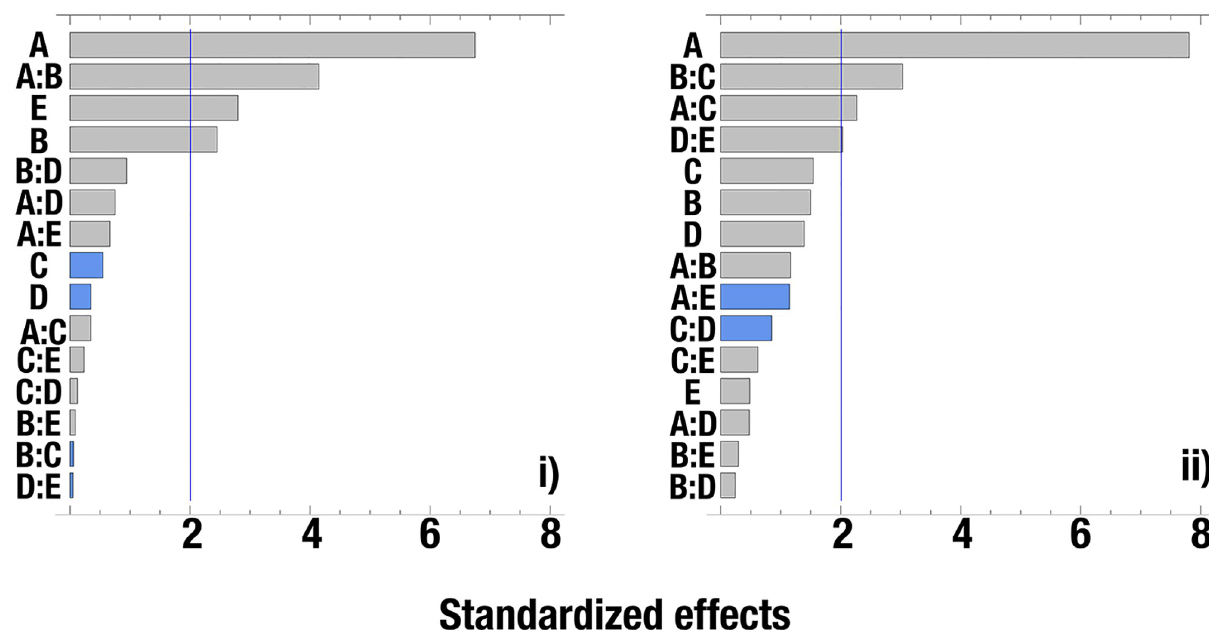
Fig 6. Pareto charts from multilevel factorial experimental design analysis. i ) Cellulolytic extract from T . reesei mixed with commercial laccase from T . versicolor . ii ) Cellulolytic extract from T . reesei mixed with enzymatic extract from D . pusillus . Parameters: A, pH; B, temperature; C, copper concentration; D, U.L -1 of laccase, and E, UPF of cellulase. Vertical lines represent the statistically significant threshold of 95% confidence with a P = 0.05, while grey and blue bars highlight positive and negative effects, respectively.